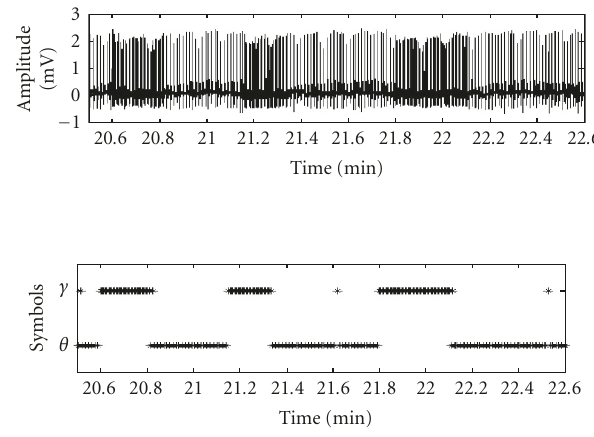
Figure 10: A patient with ventricular trigeminy.